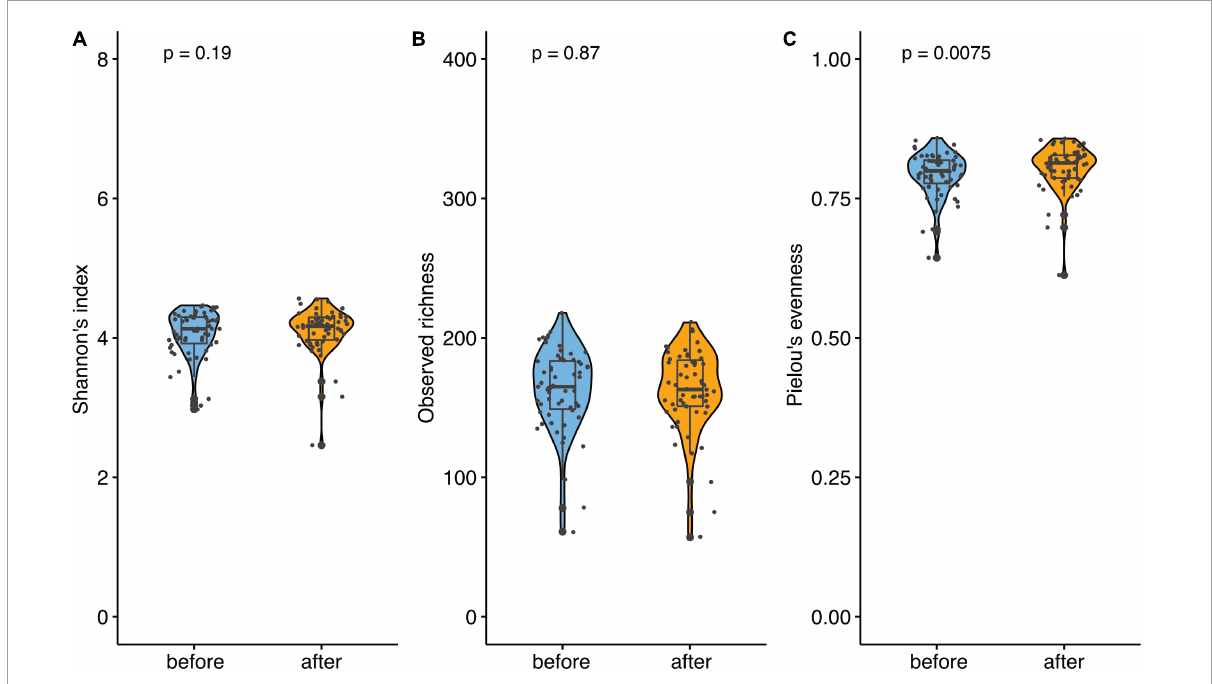
FIGURE6 Microbiome analysis of prediabetic participants before and after supplementation. (A) Comparison of Alpha diversity. Alpha diversity was estimated using the Shannon index. (B) Comparison of observed richness and (C) Pielou’s evenness. Data are presented as individual data points (dots); median and interquartile ranges are shown as boxplots; p-values were estimated using Wilcoxon